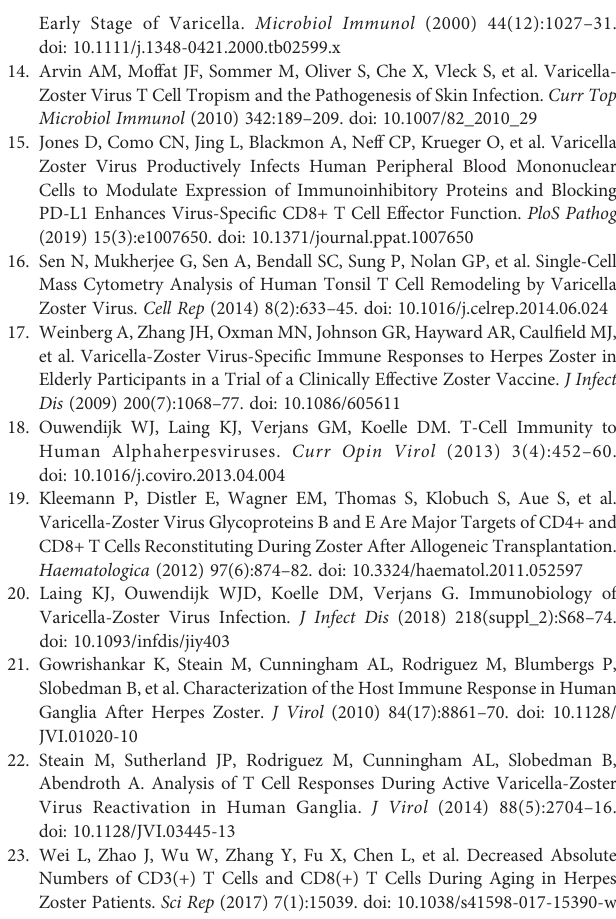
Supplementary Figure 3 | The clinical pain-related scores at different time point and correlation analysis between each immune cluster in HZ patients (related to Figure 3 ). (A) Comparisons of clinical pain-related scores, including NRS, Touch induced NRS, Numbness degree, DN4, ID-pain, GAD7, PHQ-9, Impact of pain on mood,and Impact ofpain ondailylife among HC andpatients from T 0 to T 4 . (B) The correlation analysis among immune subsets identi fi ed by CyTOF. The red boxes indicate positive correlation and blue boxes indicate negative correlation. Supplementary Figure 4 | The immune landscape of PBMCs in PHN and non- PHN patients (related to Figure 4 ). (A) the merged tSNE plot of each PHN and non- PHN sample. (B) Boxplots exhibiting the frequencies of different phenotypes of B cells, myeloid cells, NK cells, and gd T cells in PHN and non-PHN groups. Supplementary Figure 5 | The characteristics of VZV speci fi c CD8 + T cell response (related to Figure 5 ). (A) The gating strategy for getting CD69 + CD137 + CD4 + T cells or CD69 + CD137 + CD8 + T cells. Dead cells and paci fi c blue positive cells are excluded for analysis (details in method). (B) Examples displaying the FACS plot, gated on total CD8 + T cells. (C) Comparison offrequency of VZV speci fi c CD8 + T cells in peptide pools or DMSO. (D) Comparison of frequency ofVZV speci fi cCD8 + T cells in patients and HC. (E) Thecharacteristics of dynamics of VZV-speci fi c CD8 + T cells in patients at different time point after the onset of rash. (F, G) Percentages of PD-1 + cells in total CD8 + T cells (F) and VZV speci fi c CD8 + T cells (G) at different time point after the onset of rash. Supplementary Video 1 – 4 | (related to Figure 6 ). The changes of Fluo-4 AM signal intensity of ND7/23 cell line with the stimulation by PBS (Video1) and